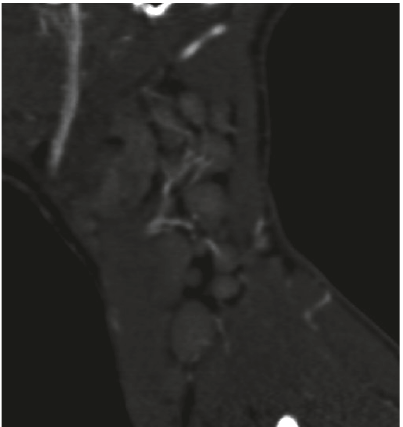
Figure2:SagittalCTangiogramdemonstratingextensivehypervas- cularity of lymph nodes in the left neck.